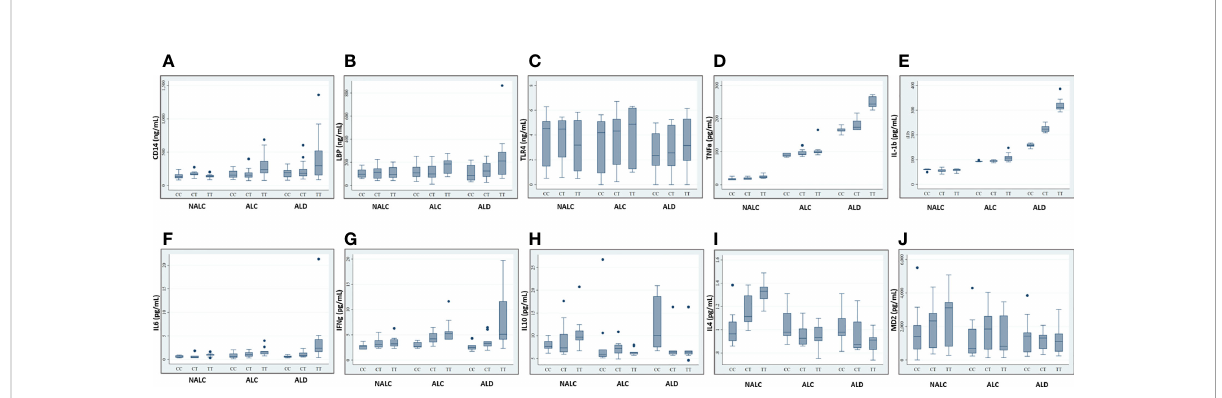
FIGURE 4 Expression of CD14 (A) , LBP (B) , TLR4 (C) , TNFa (D) , IL-1b (E) , IL6 (F) , IFNg (G) , IL10 (H) , IL4 (I) , and MD2 (J) in sera of individuals of genotype CC/CT/TT of rs2569190 among the ALD, ALC, and NALC groups. CD14, Cluster of differentiation 14; LBP, Lipopolysaccharide binding protein;